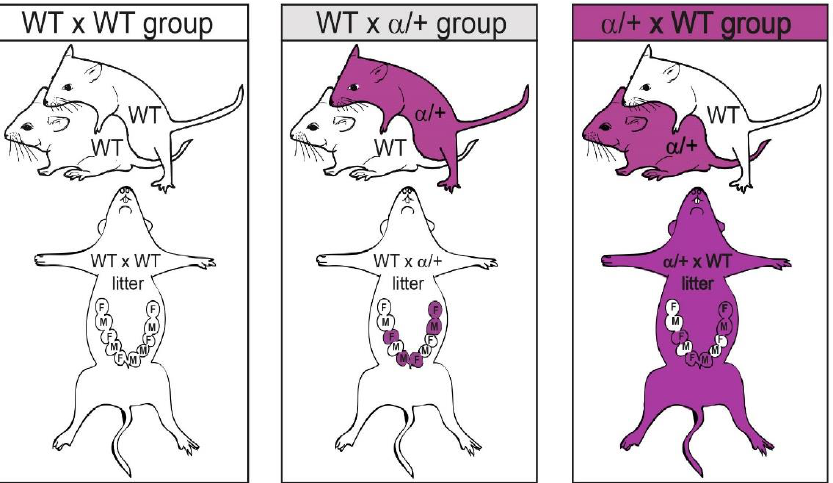
Figure 1. Illustrative figure representing the crosses used in the study. WT = wild- type; α/+ = Heterozygous Pik3ca -D933A mice; F = female fetus; M = male fetus.